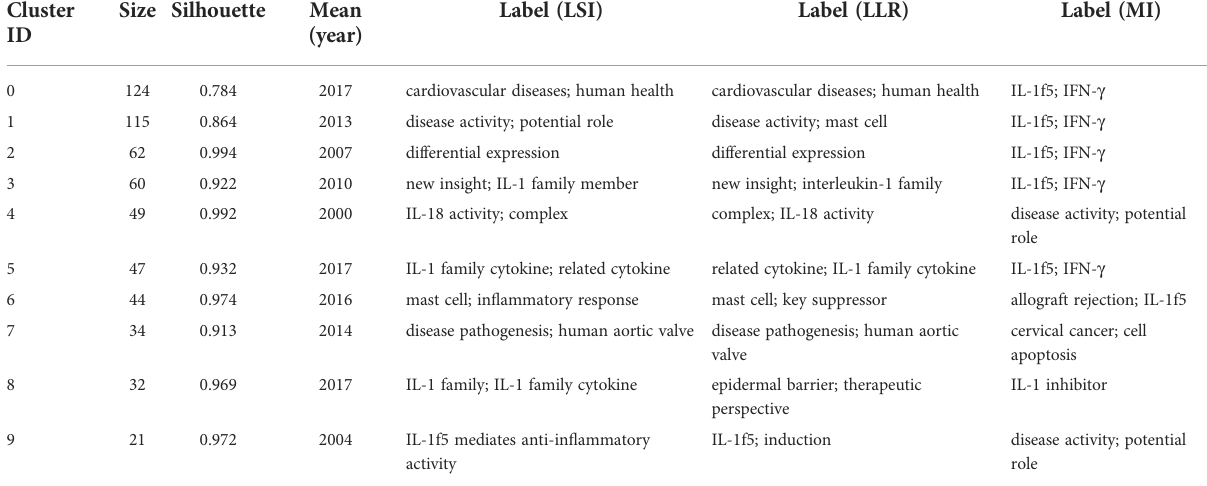
TABLE 5 Temporal major clusters of co ‐ cited references.